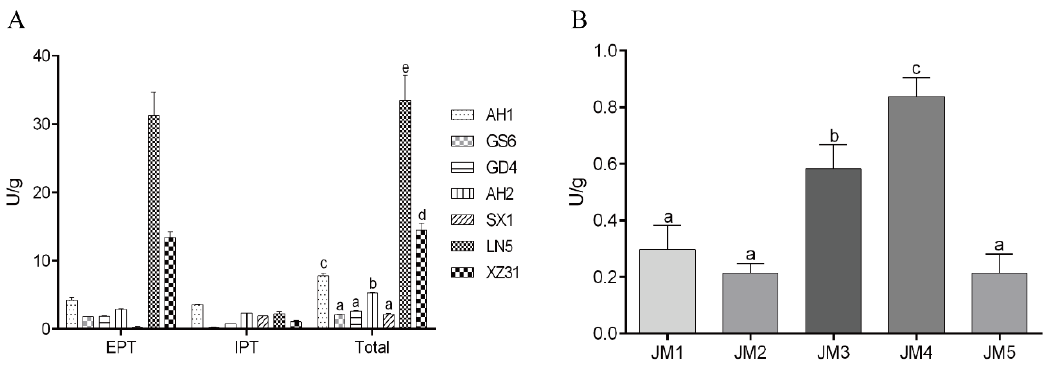
Figure 1. ( A ) The activities of extracellular proteinases (EPT) and intracellular proteinases (IPT) of seven lactic acid bacteria strains on the casein substrate. ( B ) The activities of intracellular proteinases of five yeasts on the casein substrate. Bars that do not share a common lowercase letter differ significantly ( p < 0.05) ( n = 3).